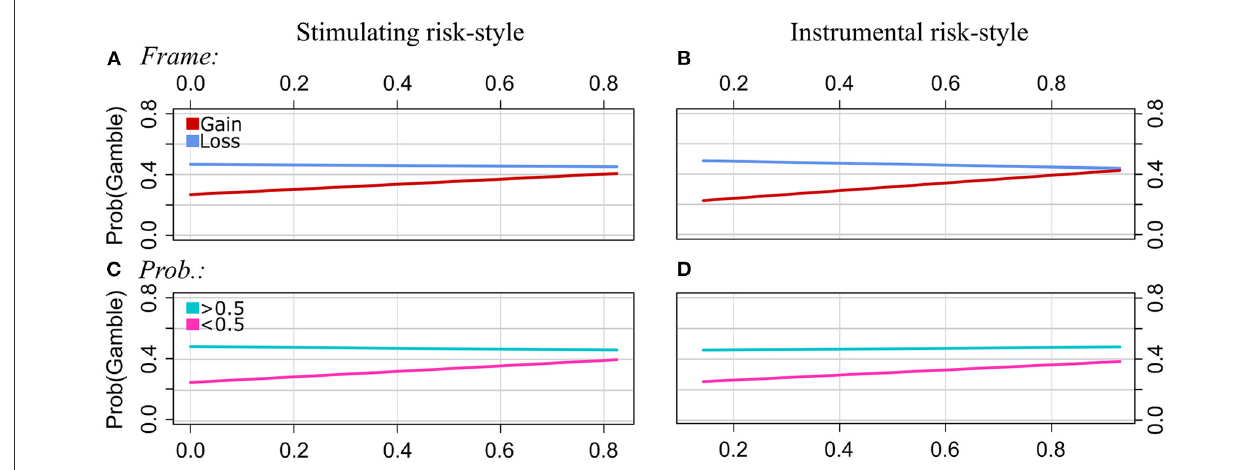
FIGURE6 Experiment 2: Regression lines of the proportions of choosing the gamble option as a function of stimulating risk-style (left column) and instrumental risk-style (right column), separately for the levels of Frame [patterns (A, B) ] and Probabilities (C, D) .